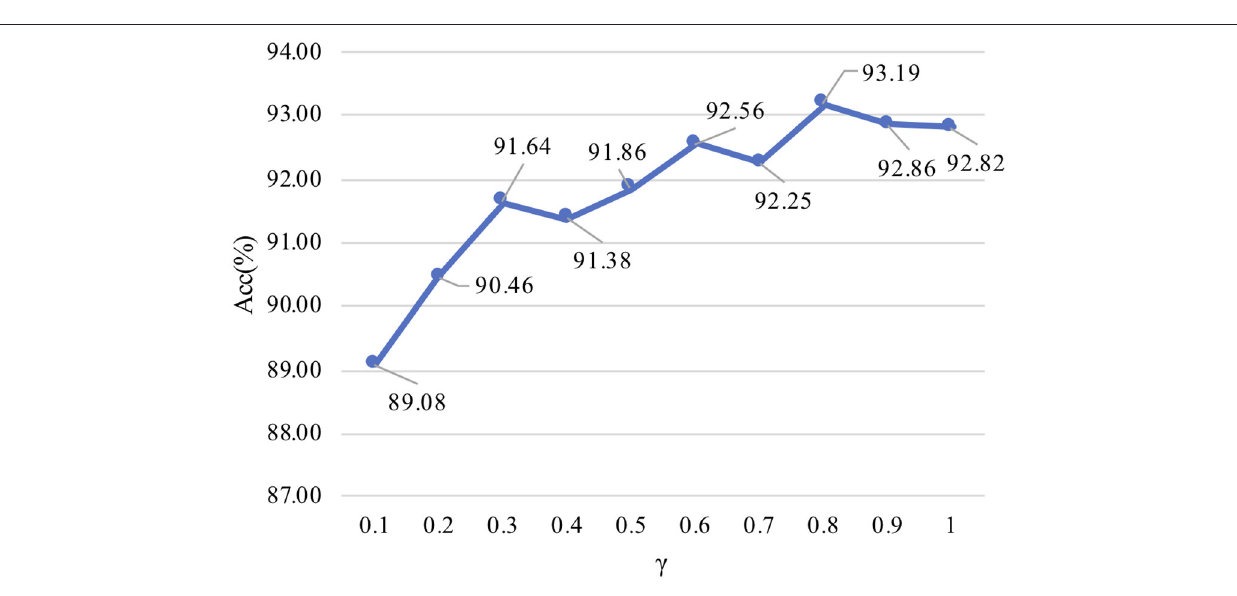
FIGURE 8 | Auxiliary training data amount. The “Acc” value represents the average accuracy for all subjects under different